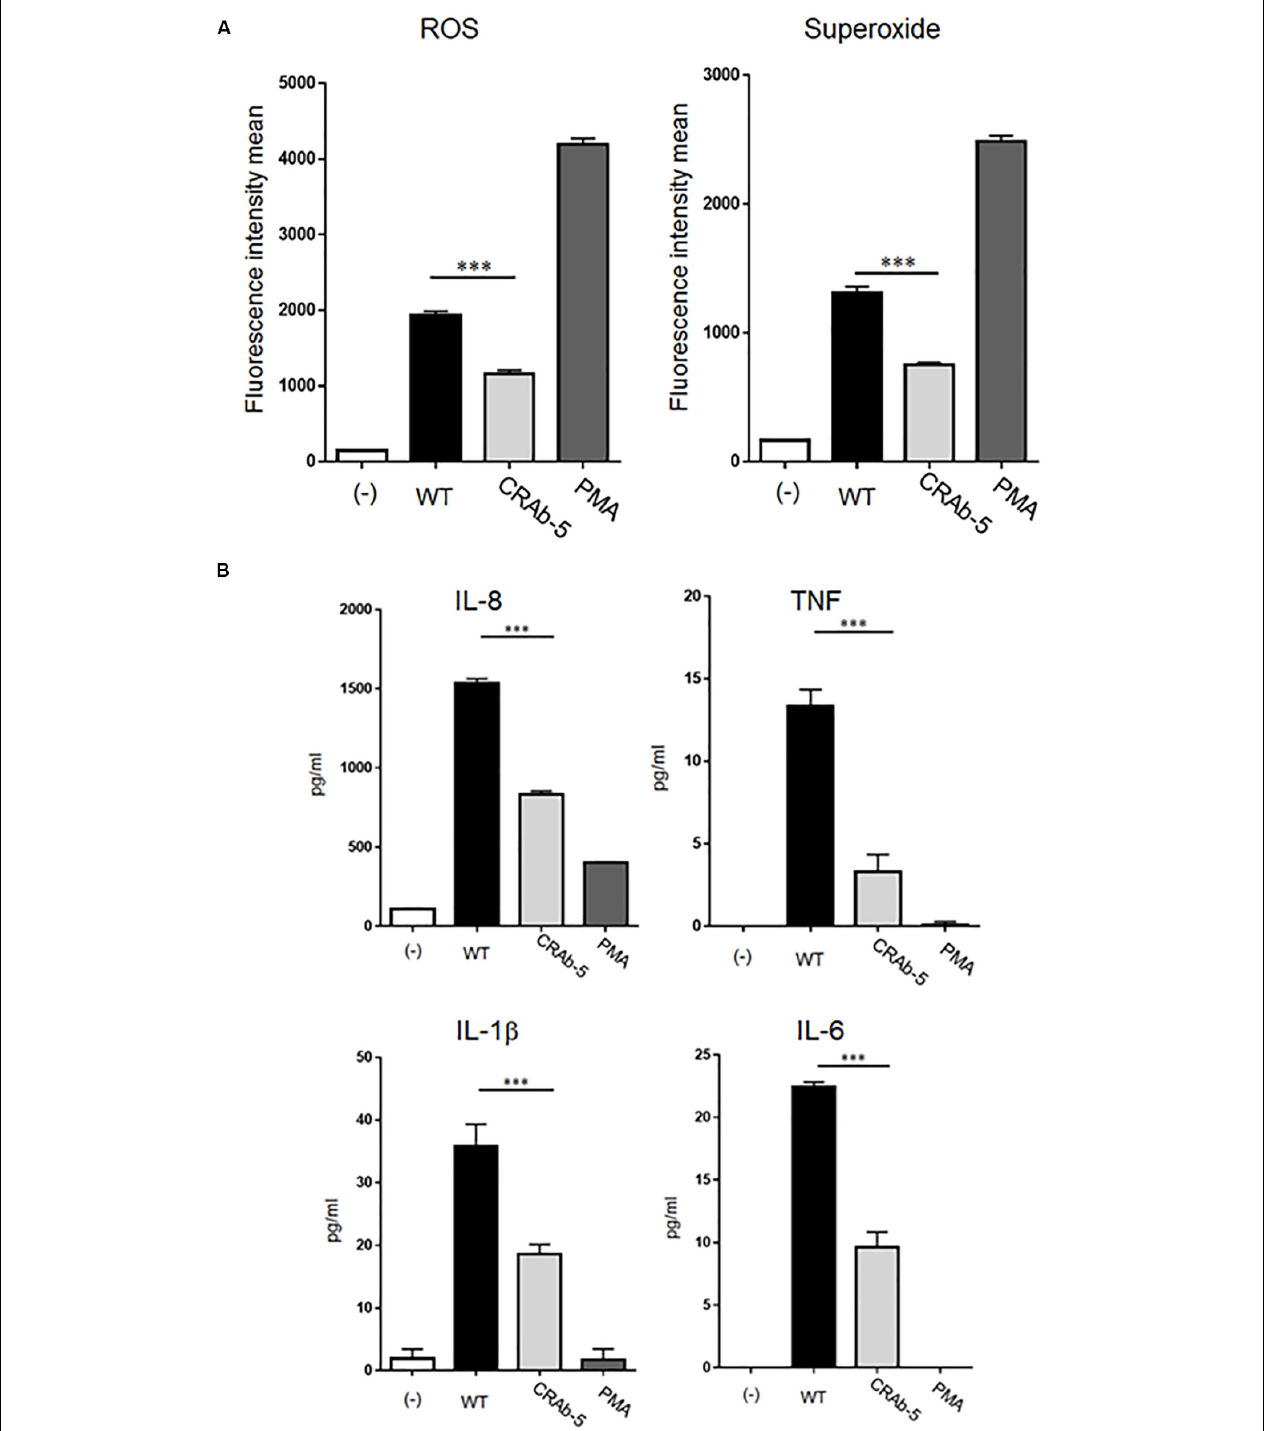
FIGURE 3 | Measurements of inflammatory response molecules secreted by neutrophils. ROS and superoxide expression levels in neutrophils challenged by bacteria (ATCC 19606: WT, colistin-resistant A. baumannii : CRAb-5) were measured by flow cytometry and a total ROS/superoxide detection kit (A) . PMA (100 nM)-stimulated neutrophils served as positive controls. Data are means ± SD; n = 5 per group. ∗∗∗ P < 0.001. (B) Inflammatory cytokines such as interleukin (IL)-8, tumor necrosis factor (TNF), IL-1 β , and IL-6 produced by neutrophils in response to bacterial stimulation were measured by the cytometric bead array system. Supernatants were obtained by co-culturing neutrophils and bacteria for 4 h. The supernatants of neutrophils alone stimulated with PMA (100 nM) served as positive controls. Data are means ± SD; n = 4 per group. ∗∗∗ P < 0.001.